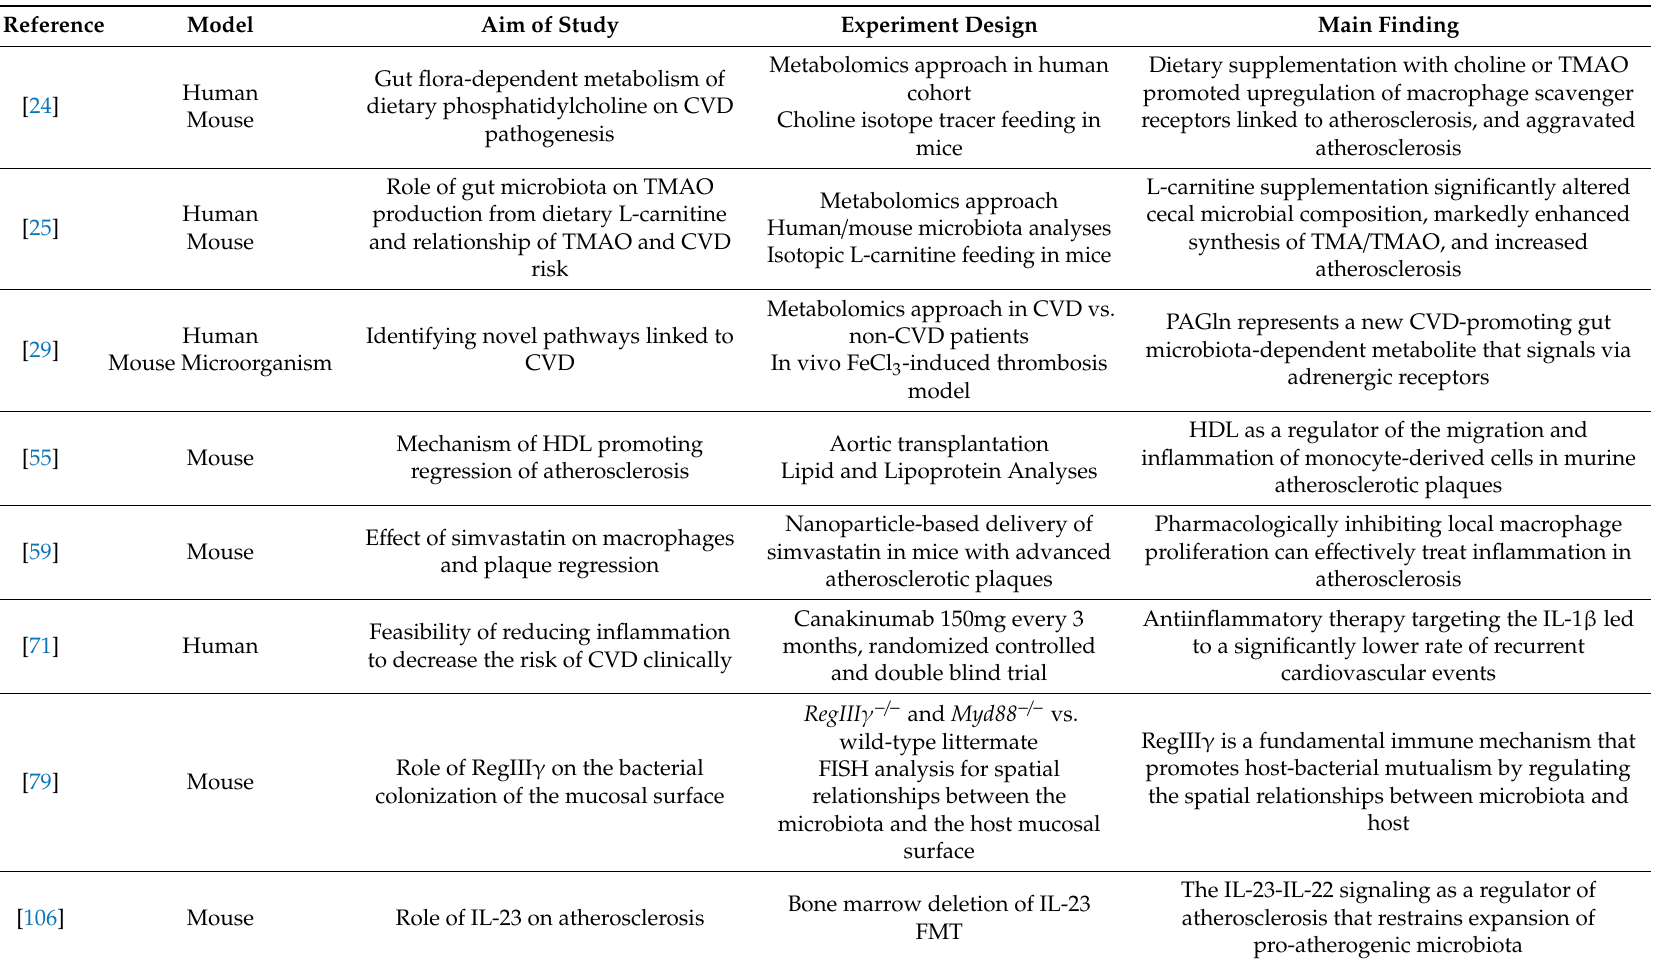
Table 2. Summary of important